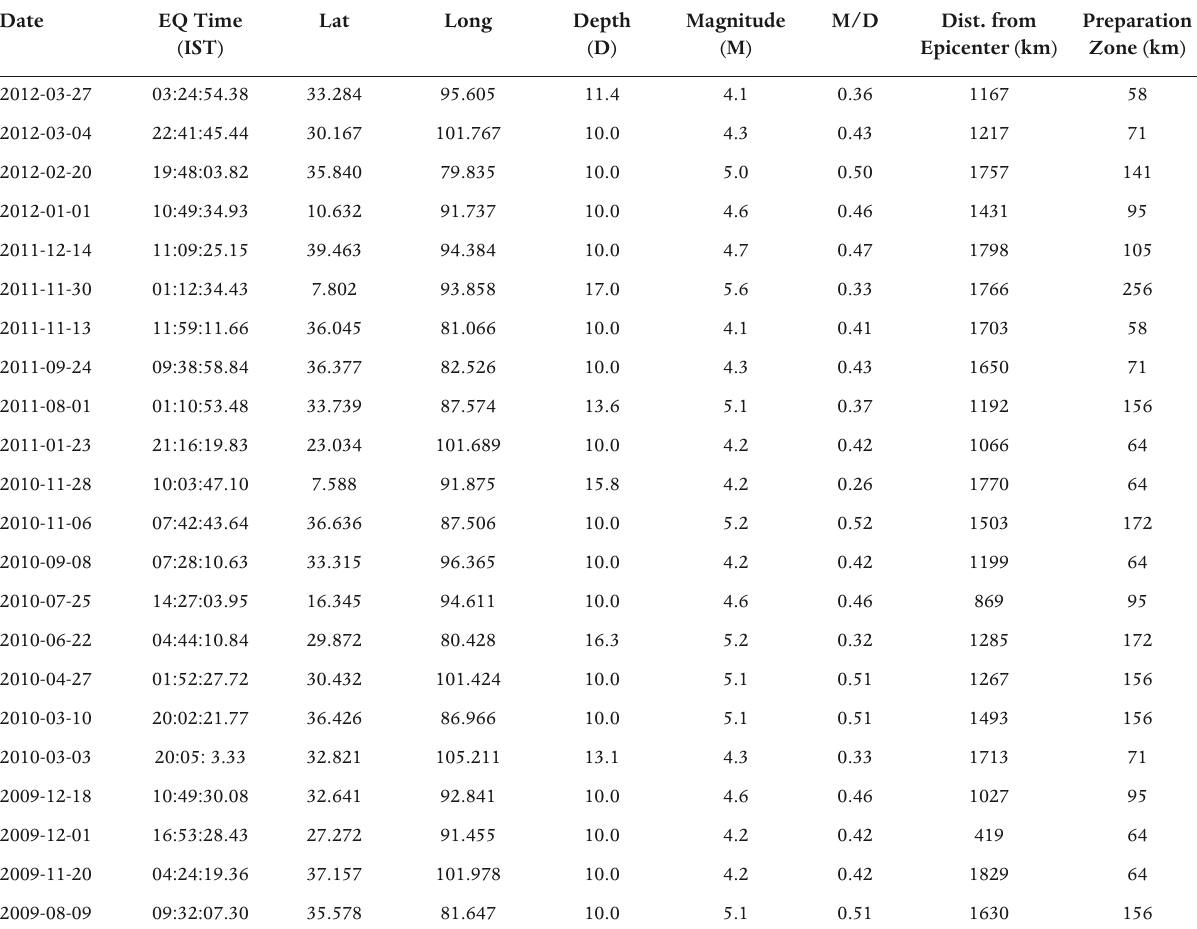
Table 2. Details of the 22 earthquake days where no precursors were observed despite the fair-weather